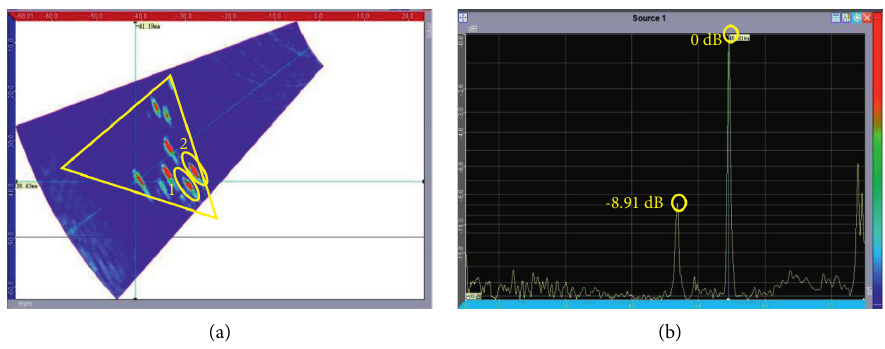
Figure 6: PAUT map: (a) sectorial scanning; (b) A